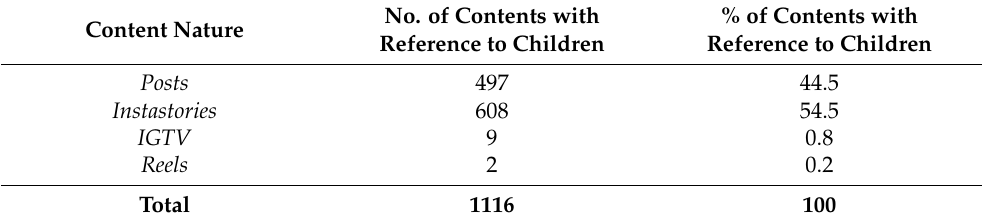
Table 2. Corpus of the